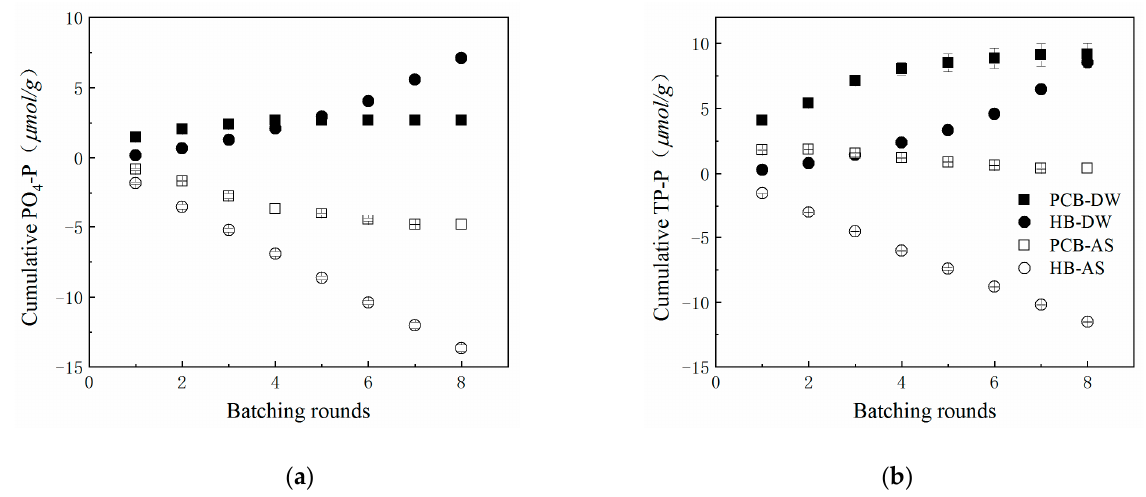
Figure 4. Cumulative phosphorus compounds leached from PCB and HB in DW or AS. ( a ) PO 4 -P; ( b )